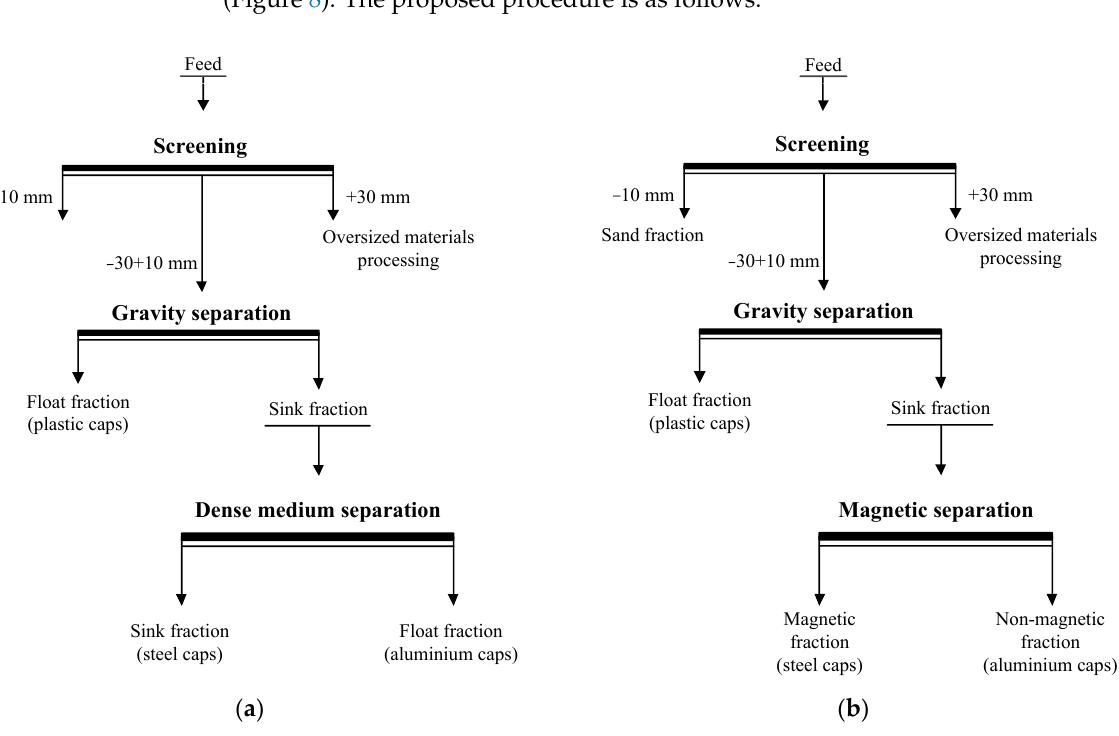
Figure 8. A simplified flowsheet for cap separation from sand shores using dense medium ( a ) and magnetic ( b ) separation in the final stage of the process operation.